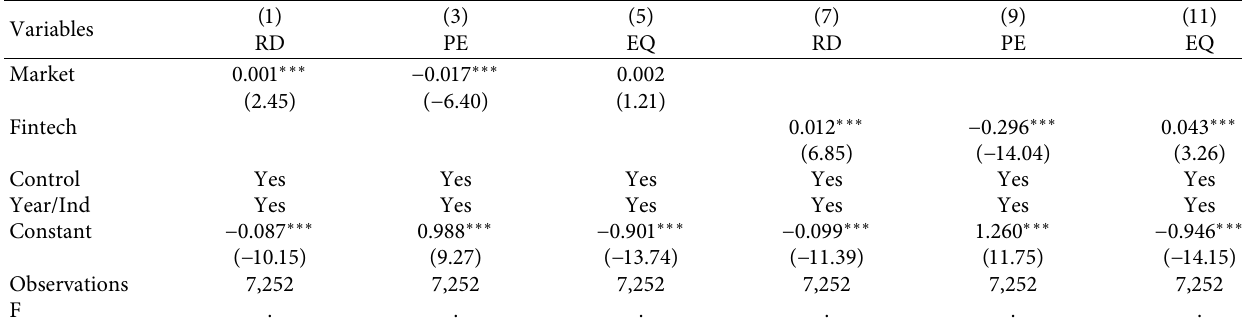
Table 13: Regression results for non-state-owned